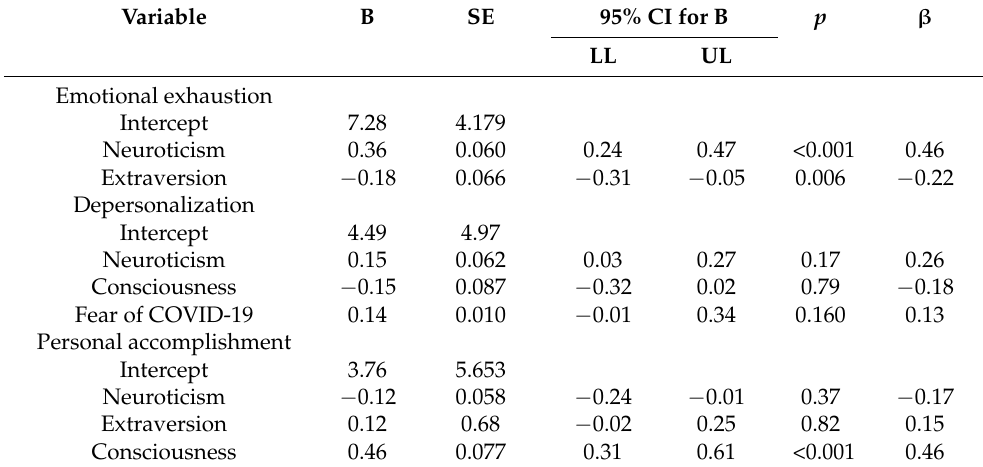
Table 5. Multiple regression models for each dimension of burnout